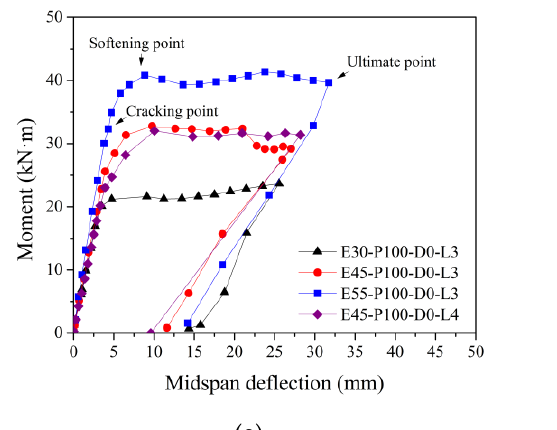
Figure 6. Load-deflection relationships of specimens: ( a ) the fully prestressed specimens; ( b ) the partially prestressed spec- imens.